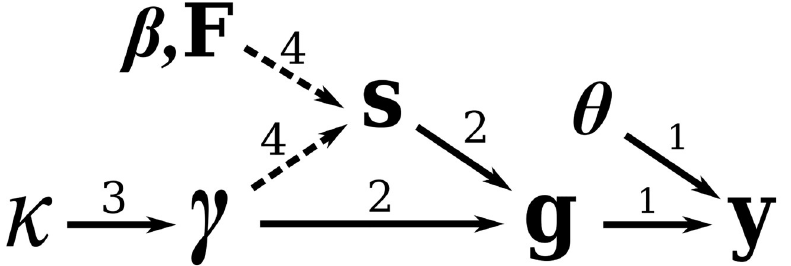
Fig 2. Dependency graph for the phylodynamic model parameters and data. Dependencies labeled 1 are explored in section, those labeled 2 are explored in section, those labeled 3 are explored in section, and those labeled 4 are explored in section. The dashed lines between γ ; β ; F and s represent preferential